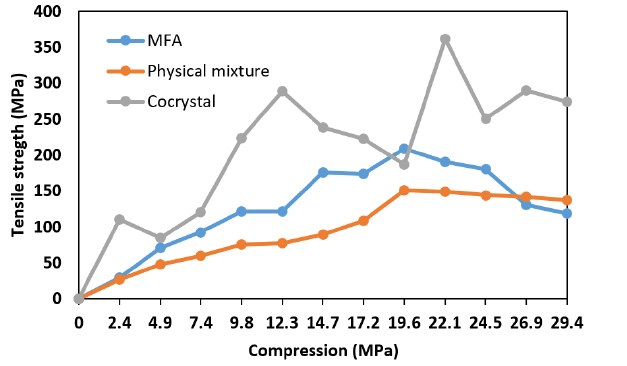
Fig. 3. The tensile strength result of MFA, MFA-NIC physical mixture and MFA-NIC cocrystal